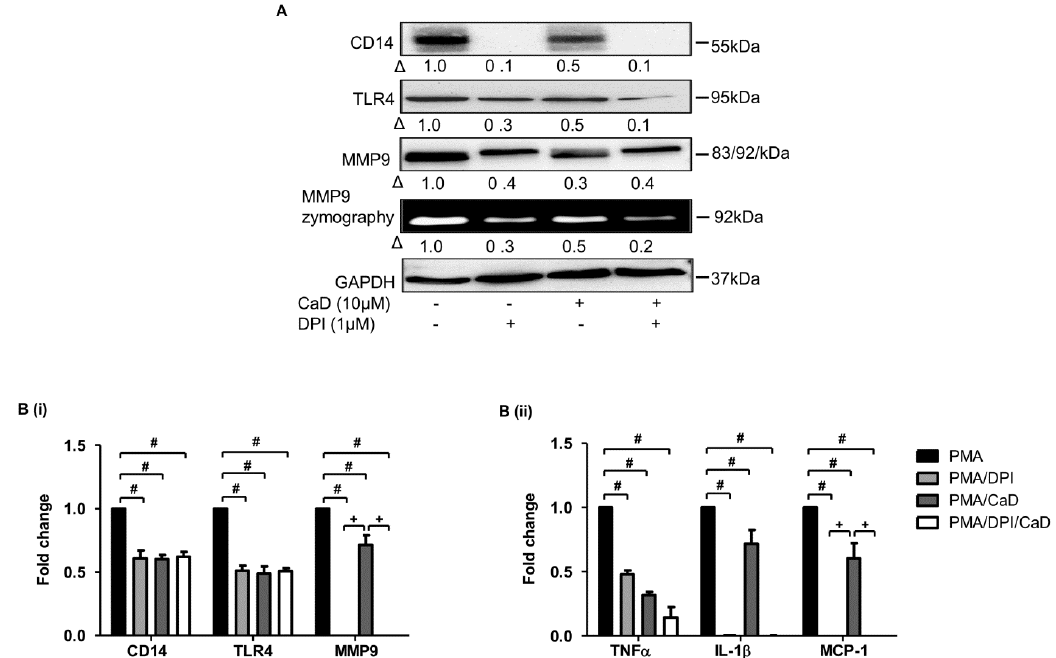
Figure 10. A NOX2 inhibitor (DPI) abrogates PMA-induced monocyte-to-macrophage differentiation and inflammation. THP-1 monocytes were pretreated with DPI for 1 h, followed by CaD for 1 h, and then treated with PMA (30 nmol/L) for 72 h. Differentiation and inflammation marker expression was measured by Western blotting ( A ), MMP9 activity was measured by gelatin zymography, and transcript ( B ) levels ( B ) were measured by quantitative RT-PCR. Δ , fold-change normalized to PMA only. ( n = 3, mean ± SEM. + p < 0.05 vs. DPI treatment, # p < 0.05 vs. PMA only, one-way ANOVA). The Western blots represent one from at least three independent experiments.